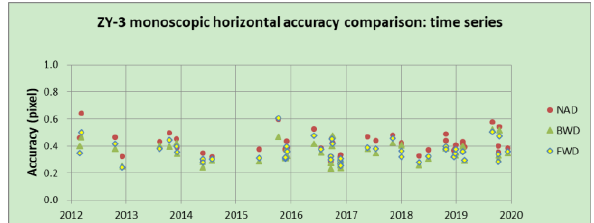
Figure 13. ZY-3 monoscopic horizontal accuracy comparison.